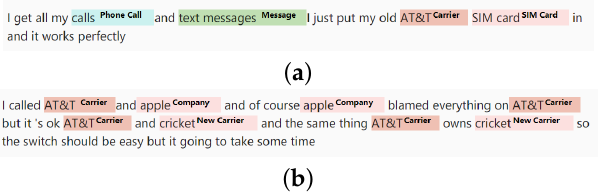
Figure 4. Visualization of BERT attention. ( a ) Carrier-named entity recognition example; ( b ) new carrier-named entity recognition discovery example.